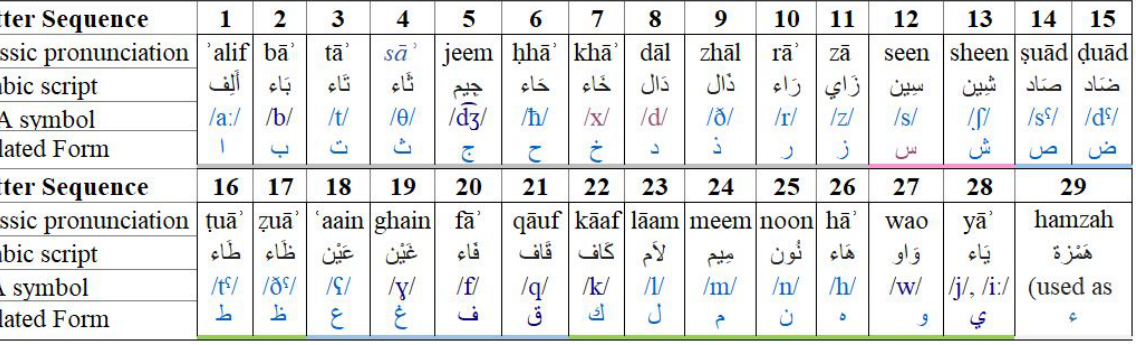
Figure 1. Arabic alphabet representation in classical, Arabic script, and international phonetic